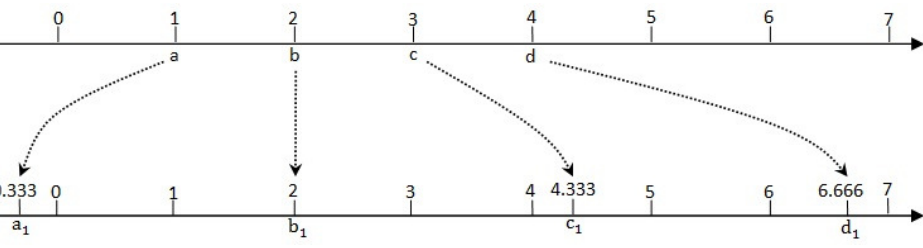
Figure 2. The illustration of the adjustment process.